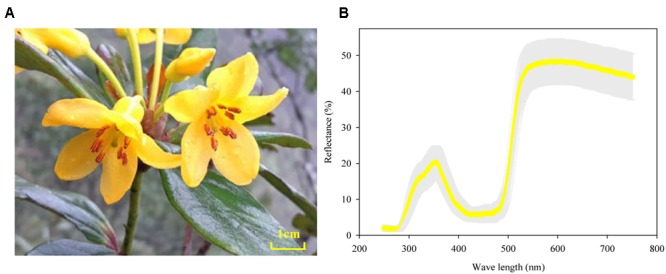
Flowers and floral reflectance spectrum of Rhododendron longipedicellatum. (A) The flower; (B) reflectance spectrum obtained by measuring 36 petals, with the standard deviation shown as a gray area.